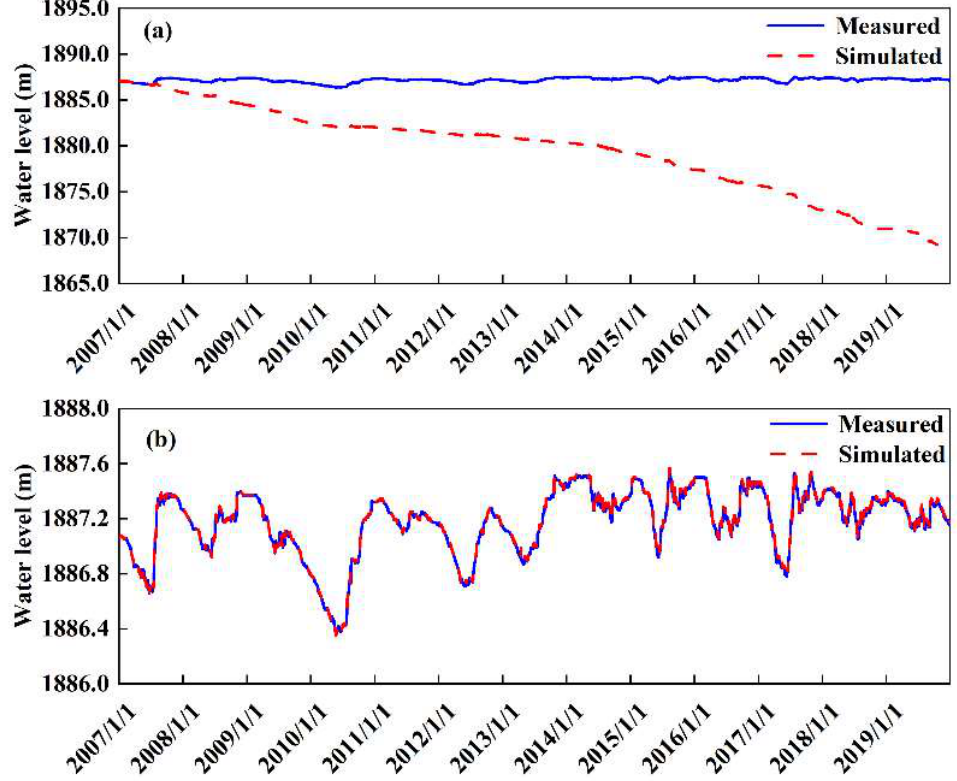
Figure 4. Simulated and measured daily water levels from 2007 to 2019: ( a ) before water compensating; ( b ) after water compensating.